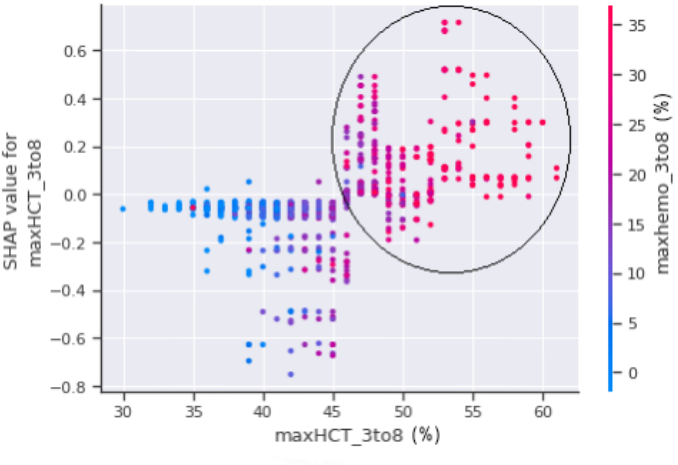
Figure 14. SHAP dependence plot between maxHCT_3to8 and